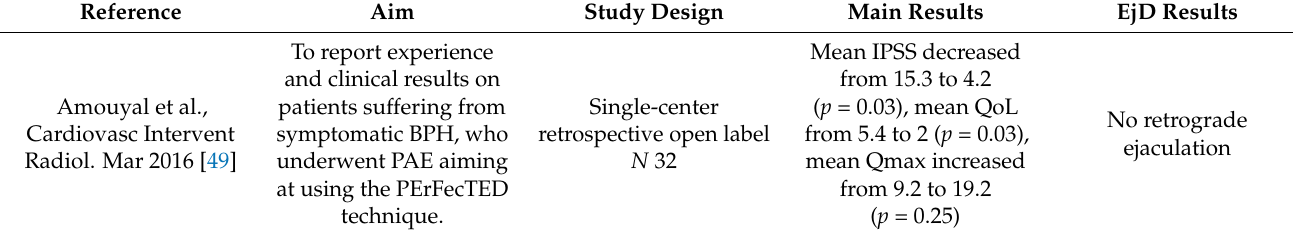
Table 8. Impact of prostate artery embolization on the ejaculatory